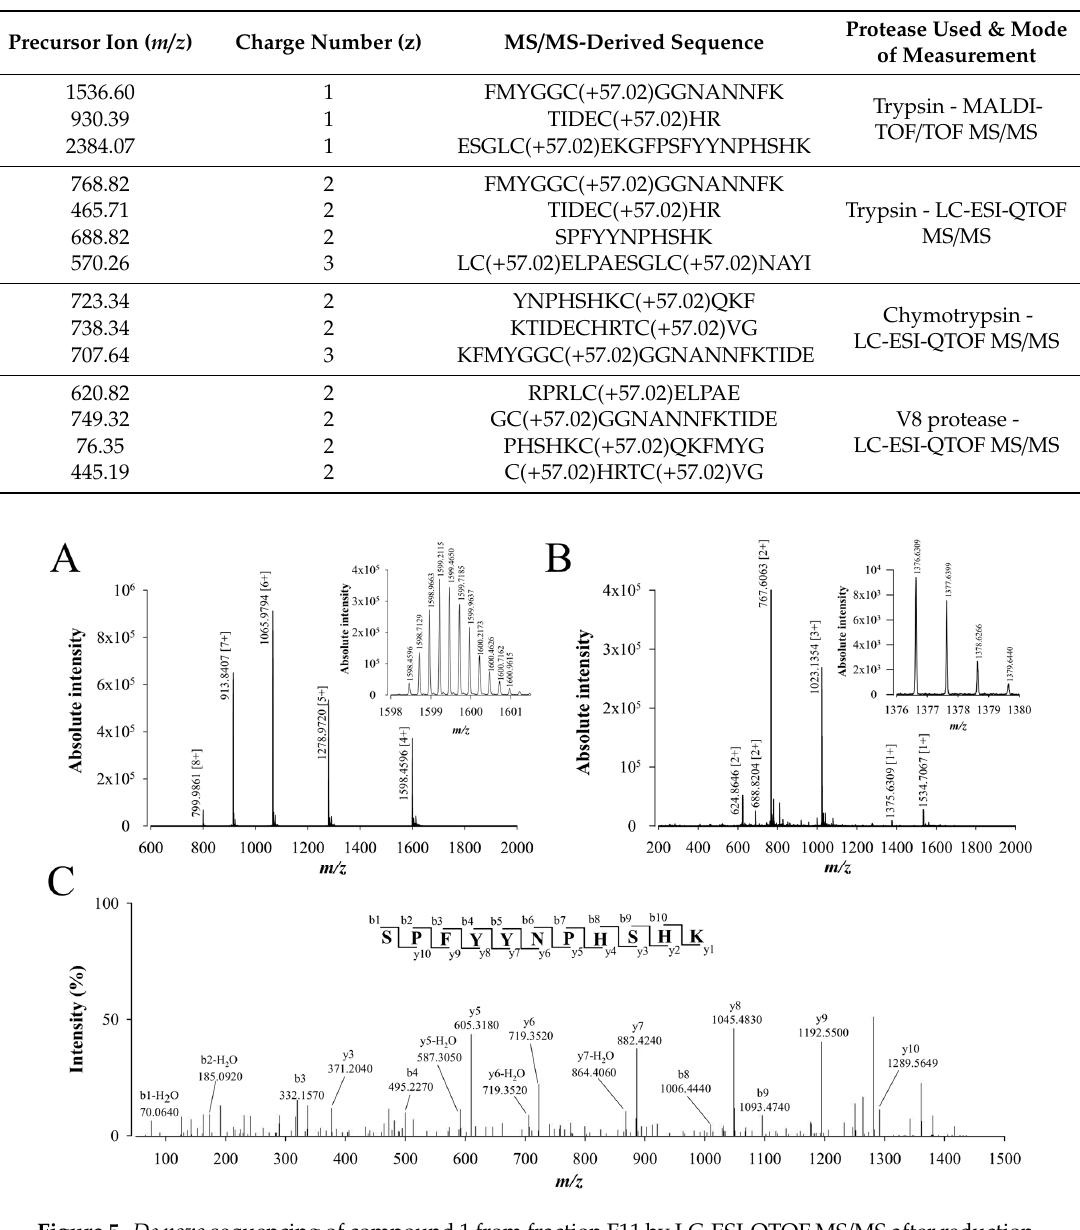
Table 1. List of walterospermin sequences obtained after MS / MS analyses of the reduced / alkylated / digested peptide. Alkylation is witnessed by an additional mass of 57.02 Da.